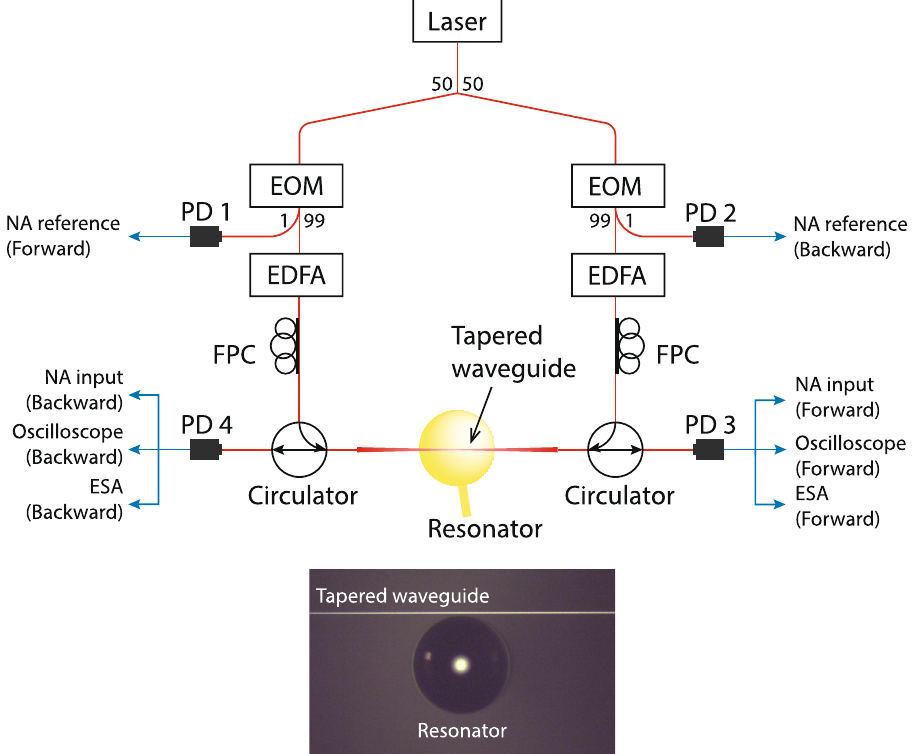
Figure 6. Experimental setup for simultaneous forward and backward probe transmission measurements is shown. We use a matched set of optical components including the electro-optic modulator (EOM), the erbium- doped fiber amplifier (EDFA), the fiber polarization contrller (FPC), the circulator and the photodetectors (PD) for the forward and backward measurements. Light is coupled to the resonator via tapered waveguide. An electronic network analyzer (NA) performs ratiometric measurements of NA reference and NA input signals (marked in figure) in the forward and backward directions. The electrical spectrum analyzer (ESA) is also